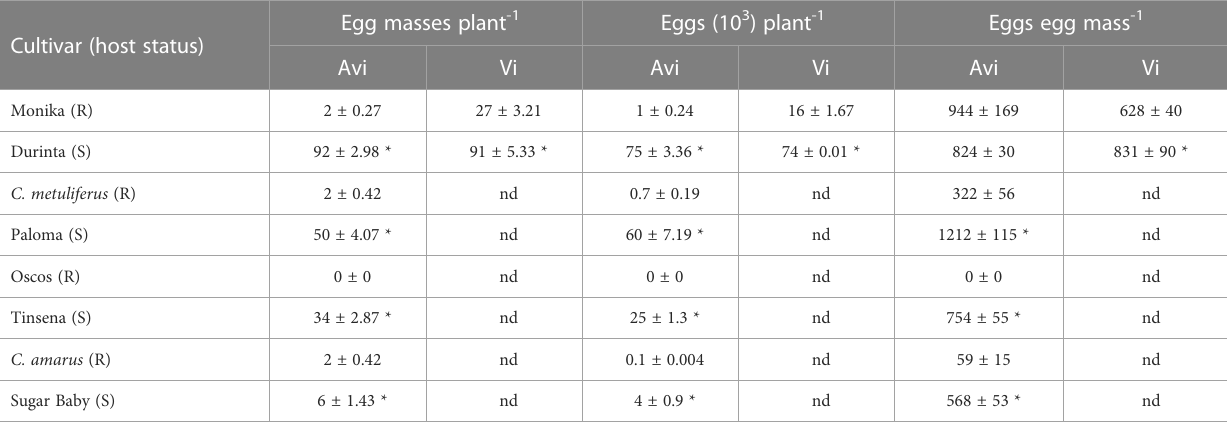
TABLE 2 N° of egg masses plant -1 , egg plant -1 and eggs egg mass -1 produced in tomato cv. Durinta (S) and Monika (R), melon cv. Paloma (S) and Cucumis metuliferus (R), pepper cv. Tinsena (S) and ‘ Oscos ’ (R) and watermelon cv. Sugar Baby (S) and Citrullus amarus (R) from the Mi1.2